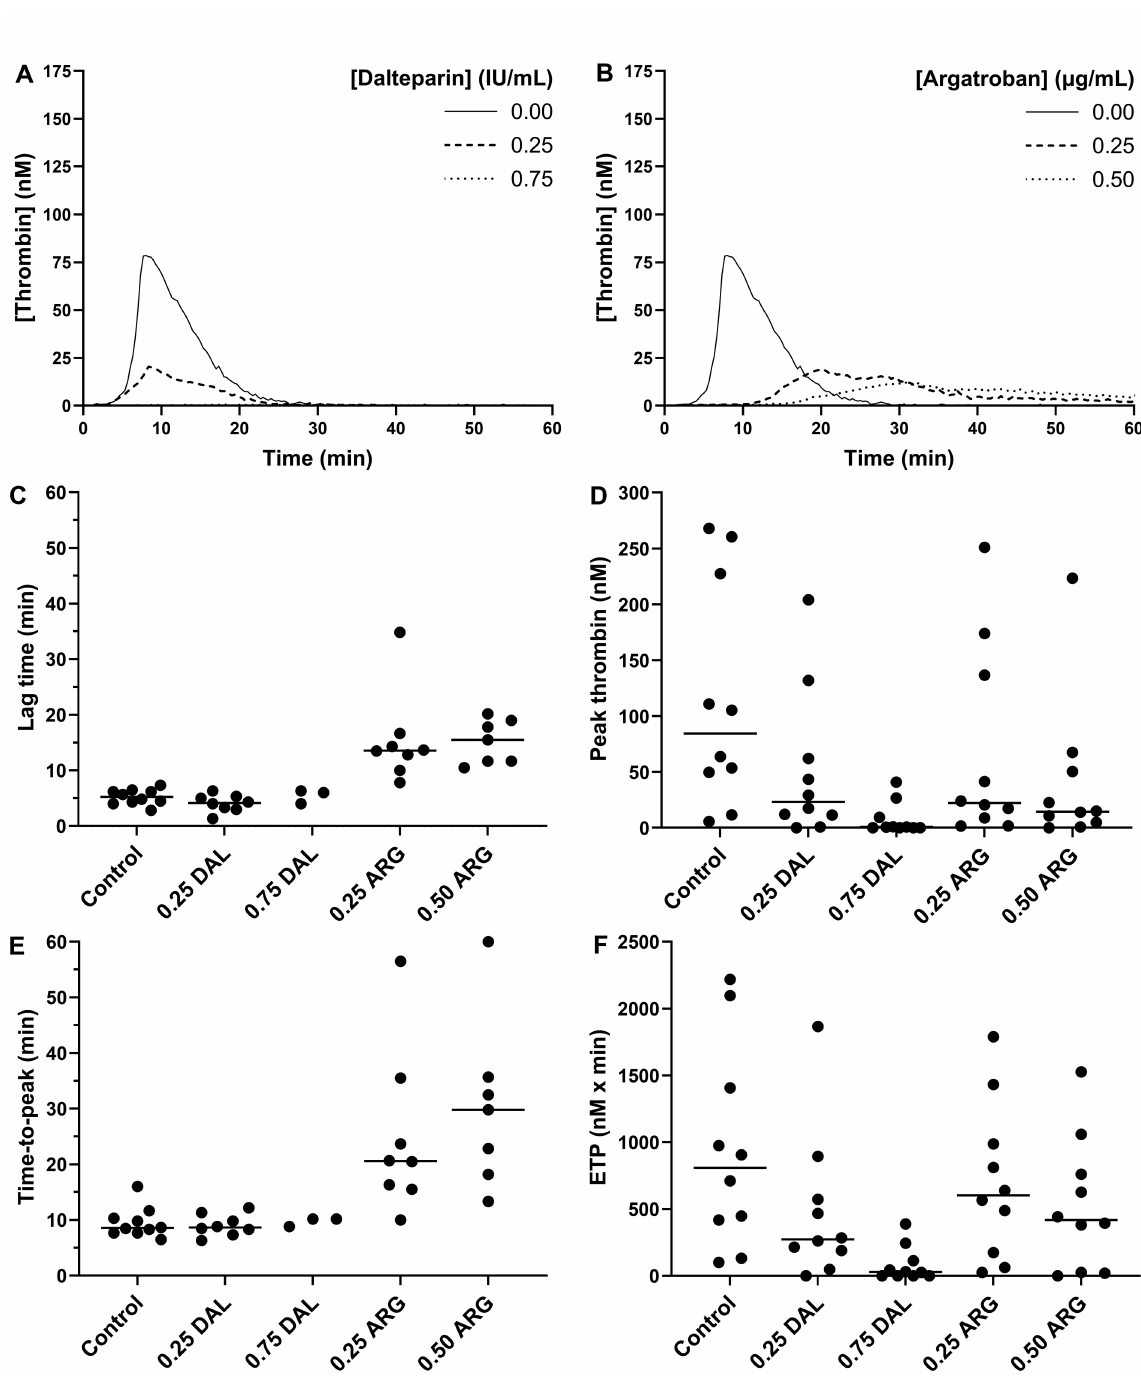
Fig. 3. Thrombin generation in platelet-poor plasma samples without anticoagulant (0.00), 0.25IU/mL and 0.75IU/mL dalteparin (DAL) samples, and 0.25 µg/mL and 0.50 µg/mL argatroban (ARG) samples from critically ill sepsispatients with new-onset thrombocytopenia ( n ¼ 10). Plasma was triggered with 5 pM tissue factor and 4 µM phospholipids. Thrombin generation curves for dalteparin (A) and argatroban (B) are shown as medians. Lag time (C) , peak thrombin (D) , time-to-peak (E) , and ETP (F) are shown as individual values with group medians as solid lines. Group medians for 0.75 IU/mL dalteparin samples in (C) and (E) could not be calculated due to no thrombin generation in seven samples.